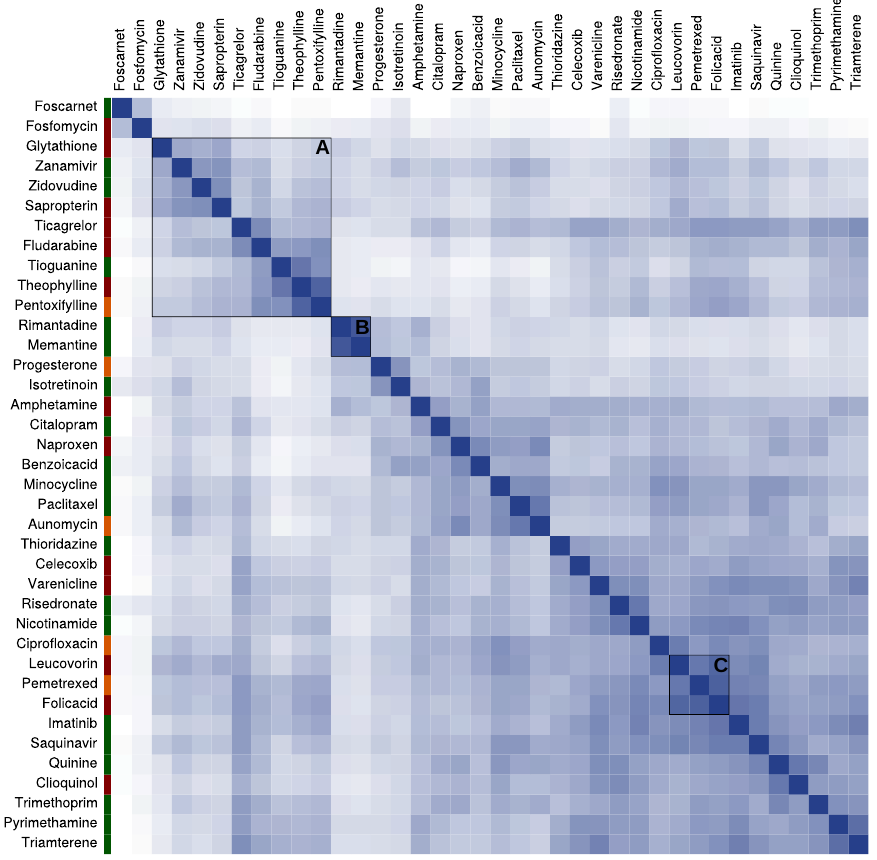
Figure 1. Chemical space of the hit candidates. The heatmap shows the pairwise similarity of the chemical structures of the hits. The similarity scores range from 0 (low) to 1 (high) with a color scheme from white to blue, respectively. The color tags on the right indicate the novelty of the drug with regard to the trypanocidal activity: direct evidence (green), indirect evidence (orange), and no previous evidence (red). Some clusters of drugs with a relatively high chemical similarity are